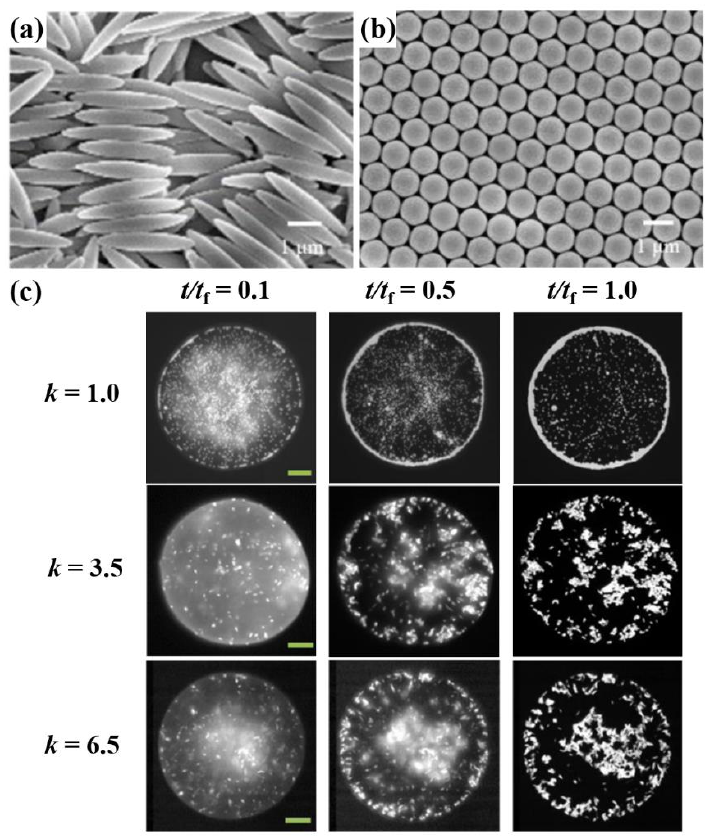
Figure 7. ( a ) A scanning electron microscopy (SEM) image of elliptical PS particles with an aspect ratio of k = 6.5. ( b ) An SEM image of spherical PS particles. ( c ) The microscopic images of the different shaped ( k = 1, spheres; k = 3.5; k = 6.5 for aspect ratio) particle migration after colloidal drop of 0.5 wt%. All scale bars are 20 µm. Reproduced with permission [63]. Copyright 2016, American Chemical Society.